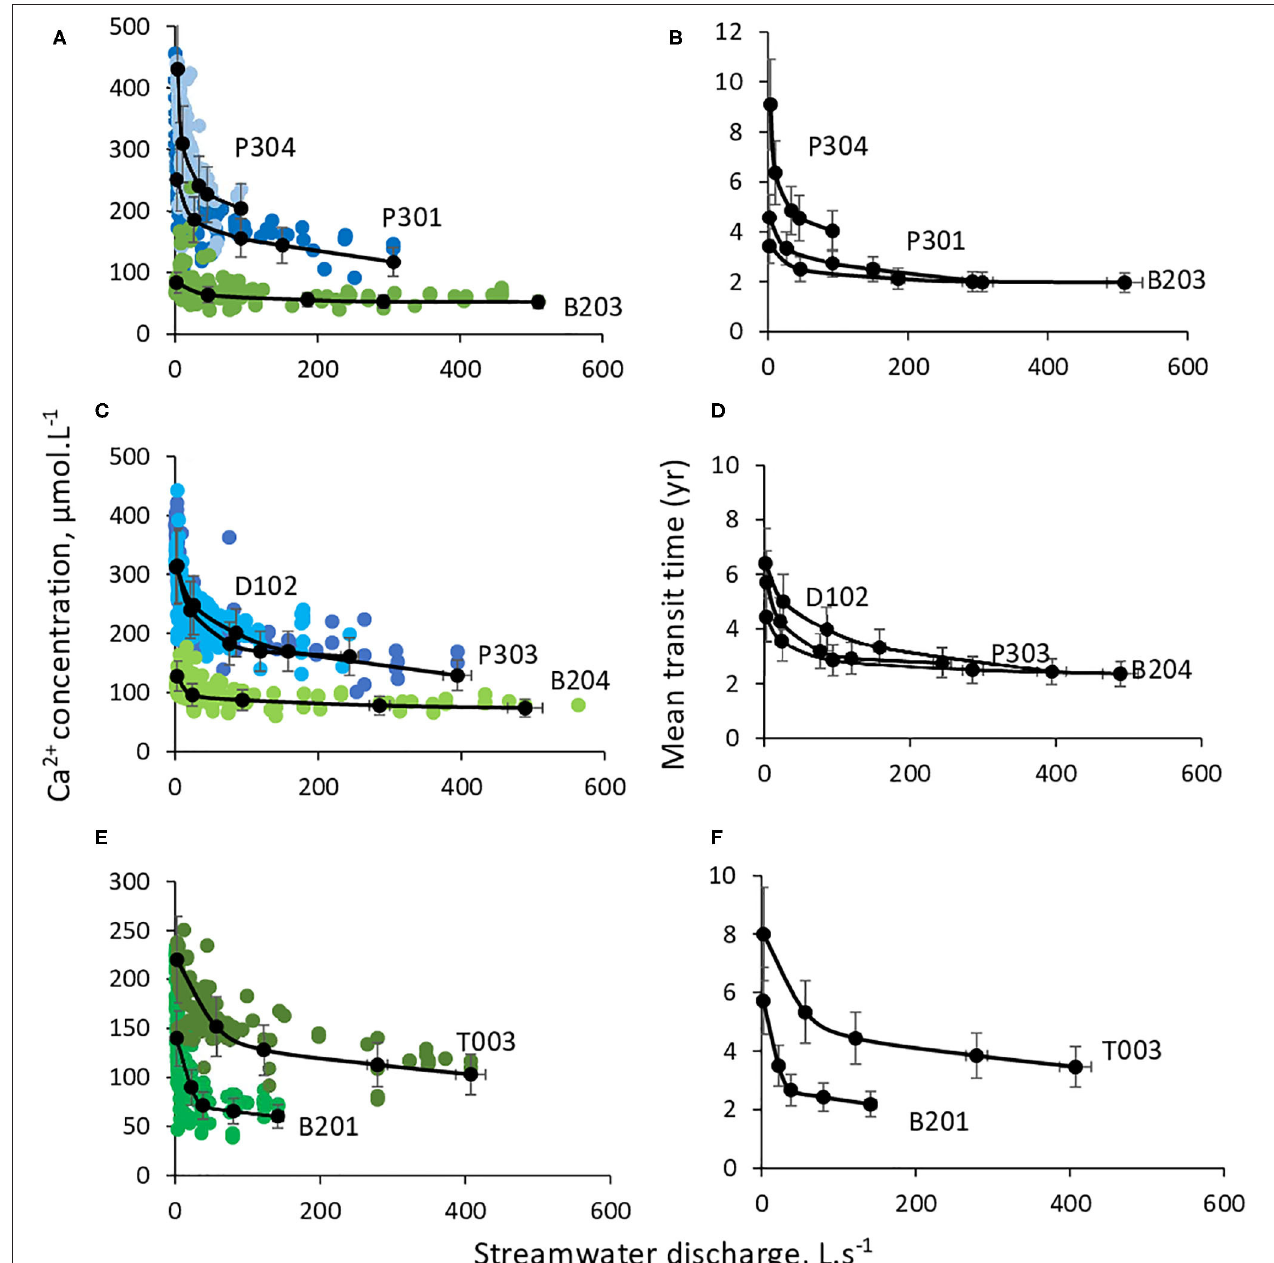
FIGURE 10 | Modeling results of C-Q relations (A,C,E) and mean transit times (B,D,F) for all the KREW stream waters. Black lines show modeling results and color points represent measured values.